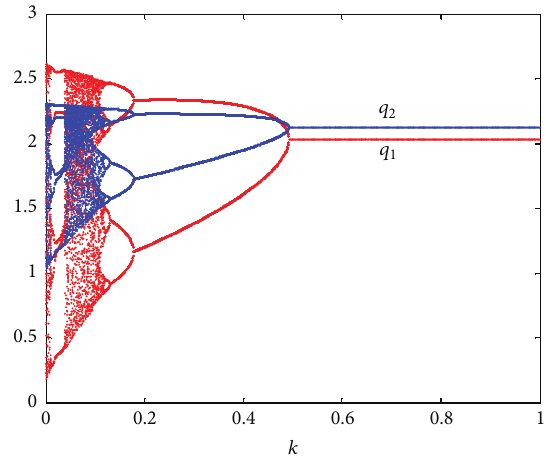
Figure 5: The bifurcation diagram before and after the system is controlled with the controlling factor 𝑘 = 0.2 .